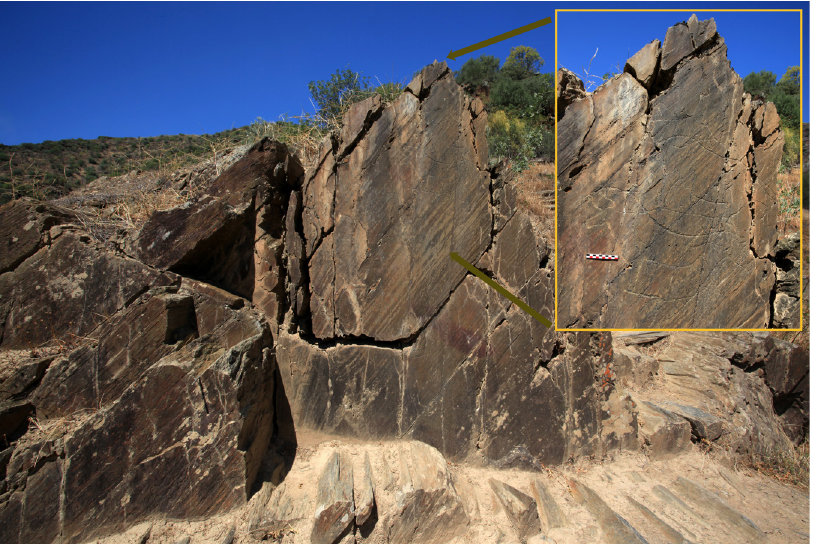
Figure 8. Canada do Inferno Rock 1, Côa Valley, Portugal. Note the concentration of motifs on the most prominent area of the outcrops. See also Figure 13. Photos: Mário